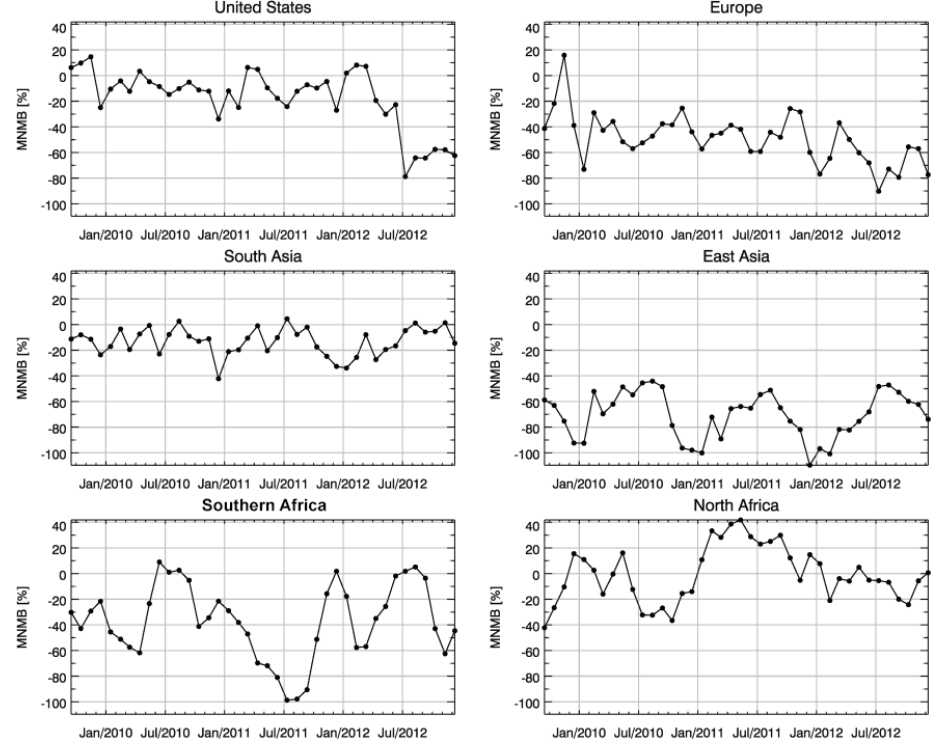
Figure 18. Modified normalised mean bias [%] for monthly means of daily tropospheric NO 2 VCD averaged over different regions (see Fig. 1 for latitudinal and longitudinal boundaries) derived from the MACC_osuite simulations and satellite observations (SCIAMACHY up to March 2012, GOME-2 from April 2012 to December 2012). Top: United States (left), Europe (right), second row: South Asia (left), East Asia (right); bottom: southern Africa (left), North Africa (right). Values have been calculated separately for each